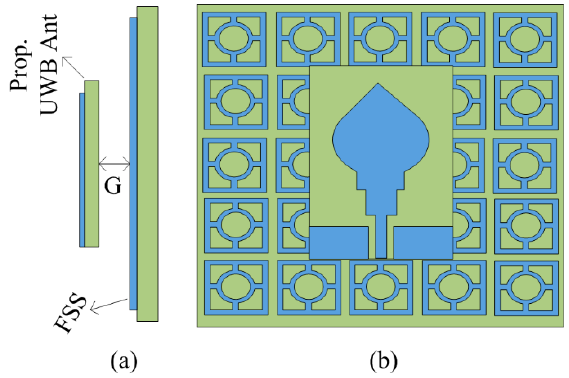
Figure 6. Frequency selective surface-loaded UWB antenna: ( a ) side view; ( b ) top view (G = 9 mm).